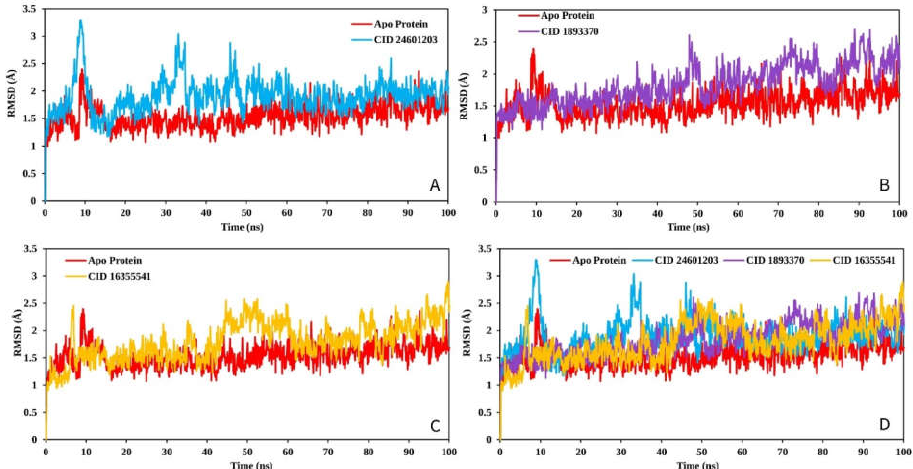
Figure 8. The RMSD values extracted for the Cα atoms of the three selected compounds in complex with the FAK1 protein (red) for the compounds ( A ) CID: 24601203 (blue), ( B ) CID: 1893370 (purple), ( C ) CID: 16355541 (yellow) and, ( D ) all the RMSD for all compounds and the protein together.